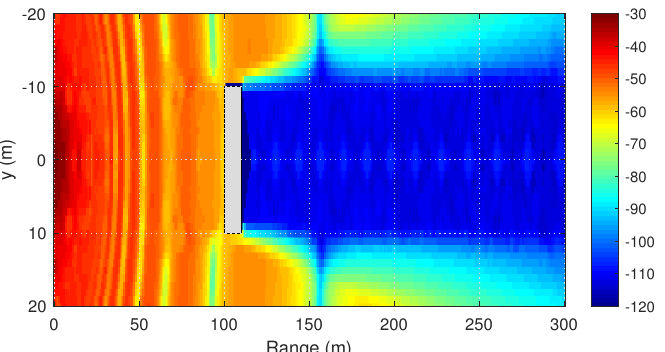
Figure 4. Diffraction on a cuboid. Two-dimensional distribution of the signal level (dBm) at the height of 1.5 m, calculated by the RT method.